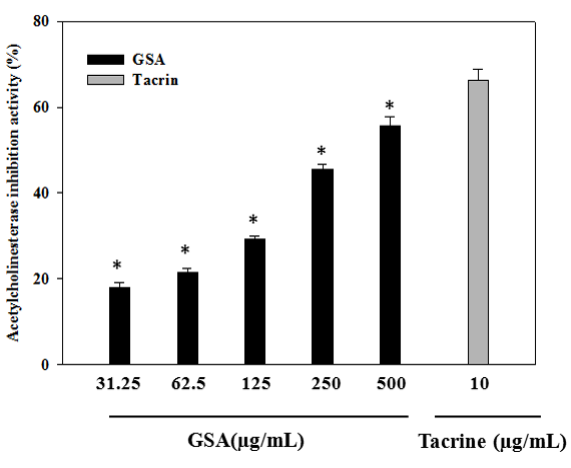
Figure 5. Acetylcholinesterase inhibitory activity of GSA. Values represent the mean ± SD ( n = 3). * p < 0.05, compare to the positive control